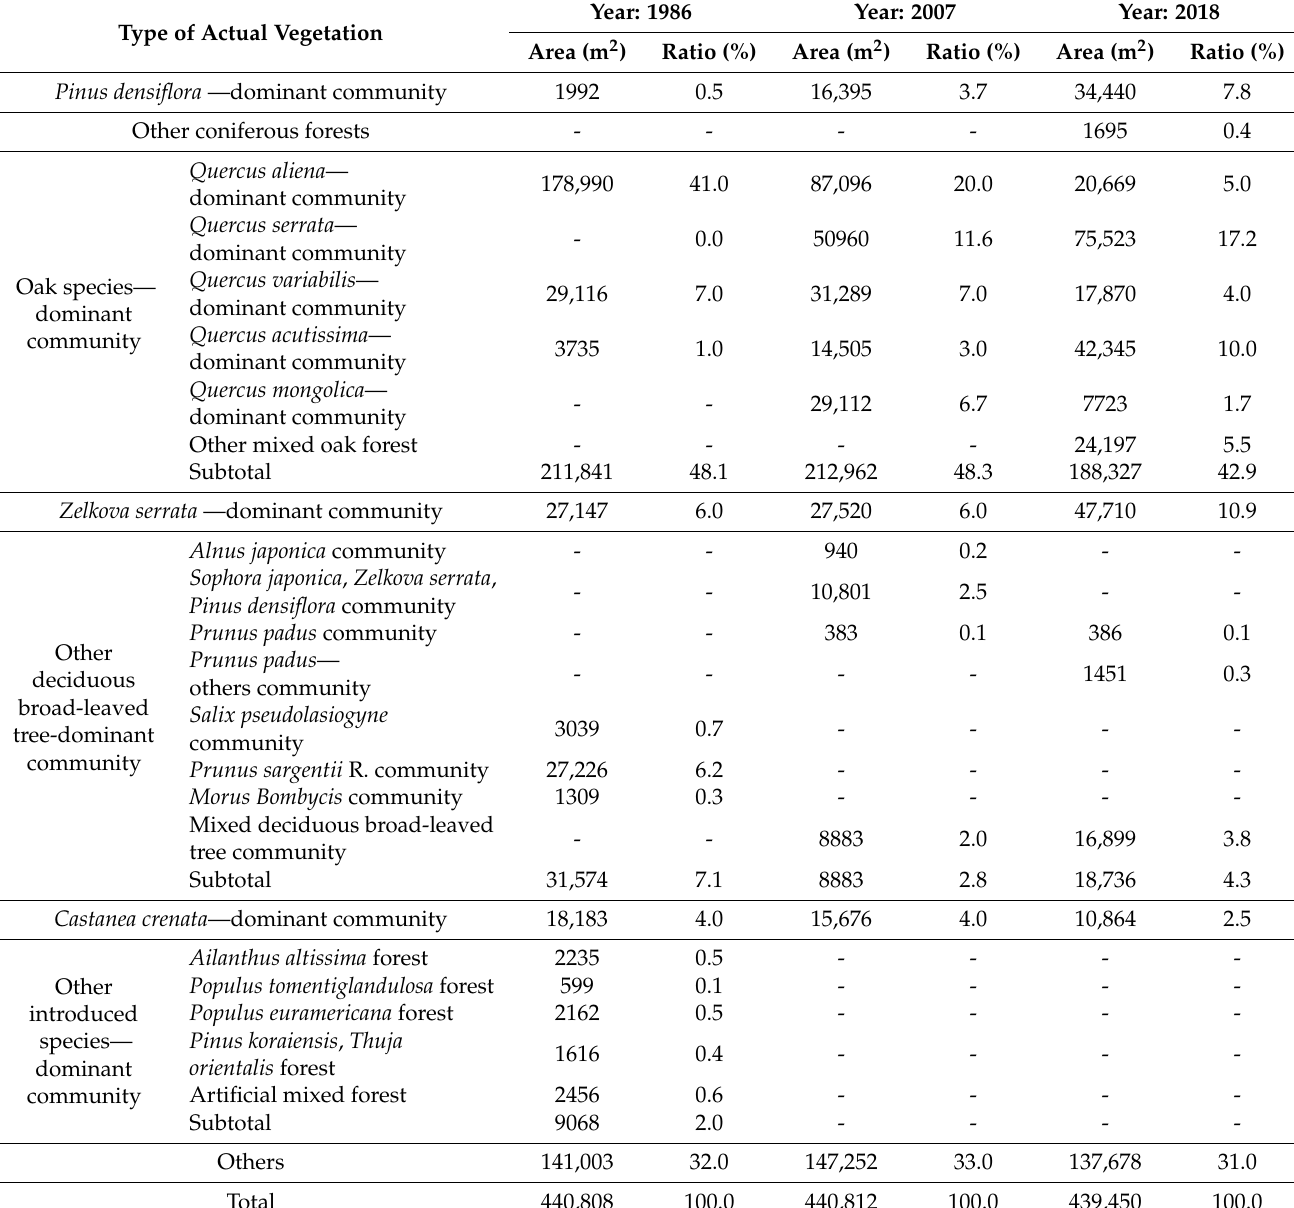
Table 3. Variation in the actual vegetation in ecological landscape preservation areas of the Changdeokgung Rear Garden in a 32-year period